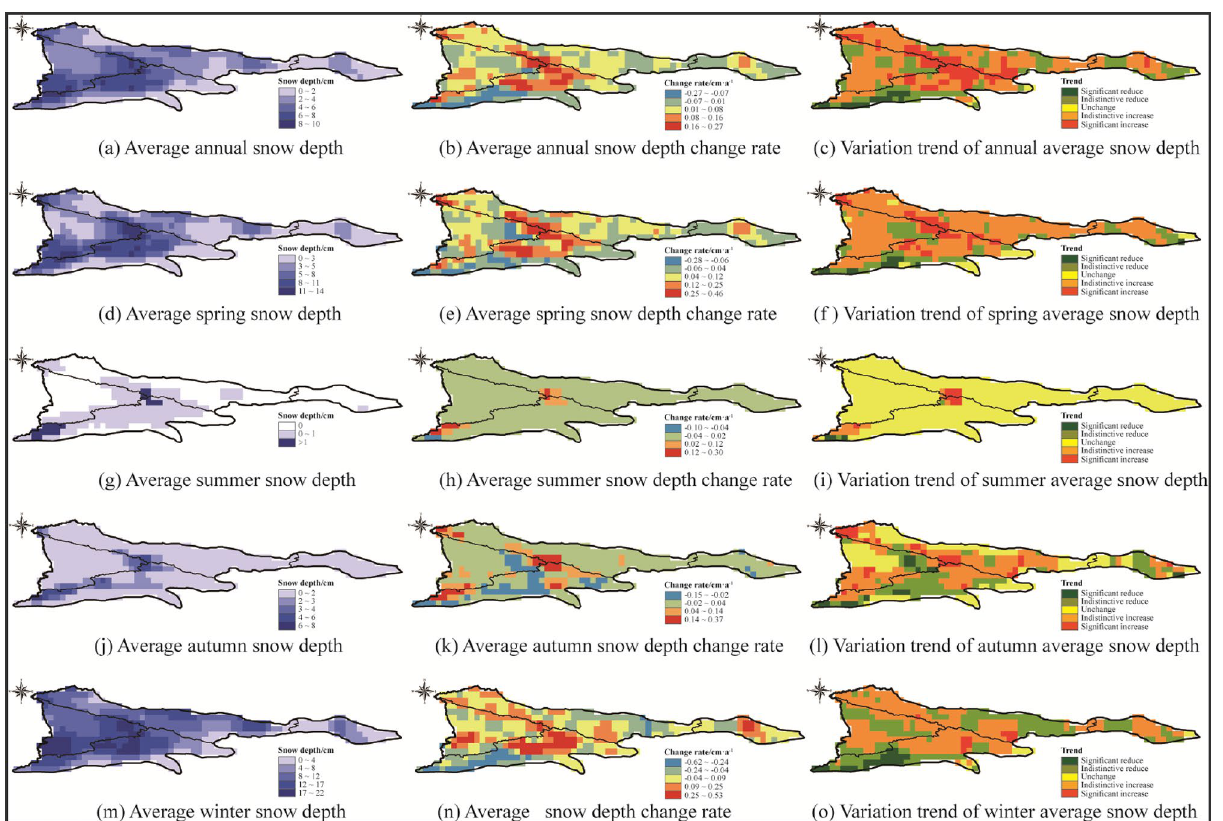
Figure 6. Variation of annual and seasonal SD. The maps were generated by ArcGIS 10.2, URL: http:// suppo rt. esri. com/ Produ cts/ Deskt op/ arcgis- deskt op/ arcmap/ 10-2- 2# overv iew.